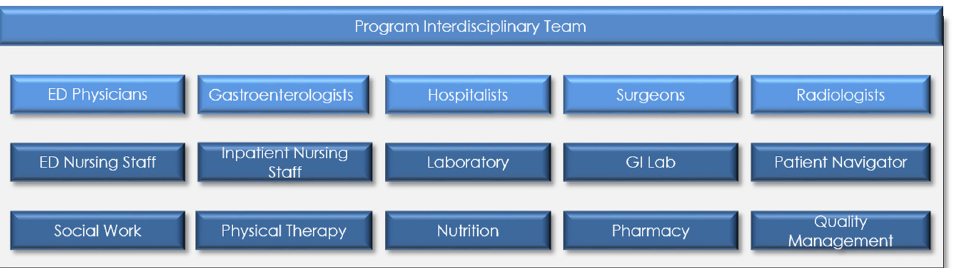
Figure 2. Interdisciplinary team of Pancreas CoE, ED = Emergency Department, GI = Gastroenterol ‐ ogy.